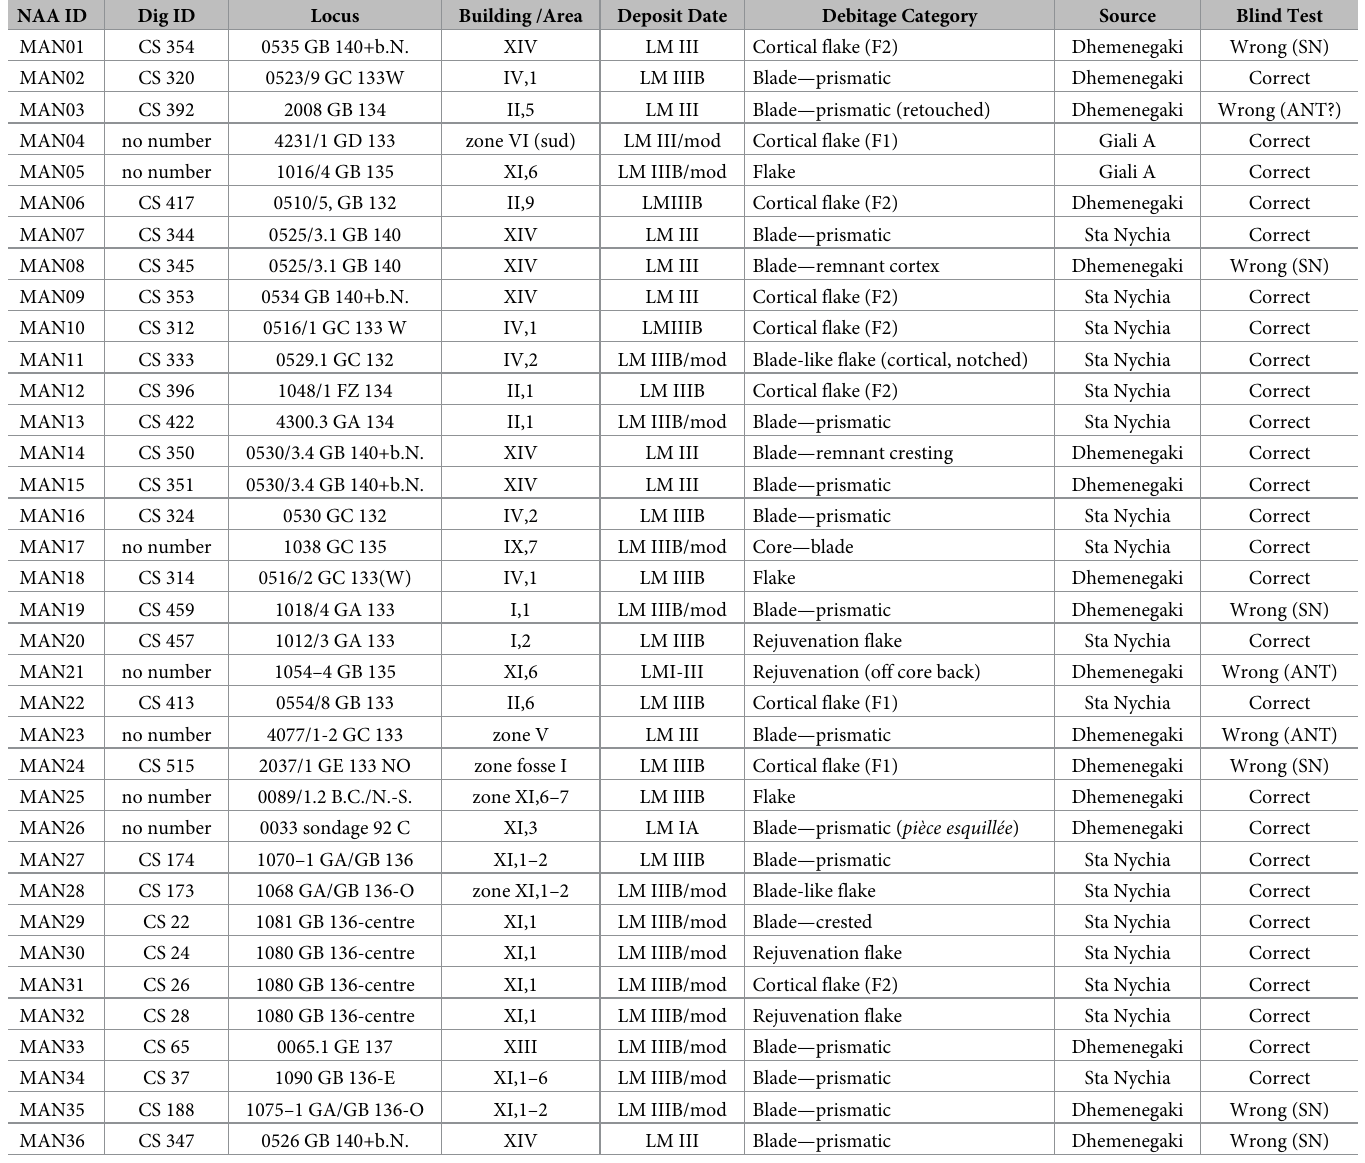
Table 2. Contextual, techno-typological, source, and blind test data for the analysed Quartier Nu